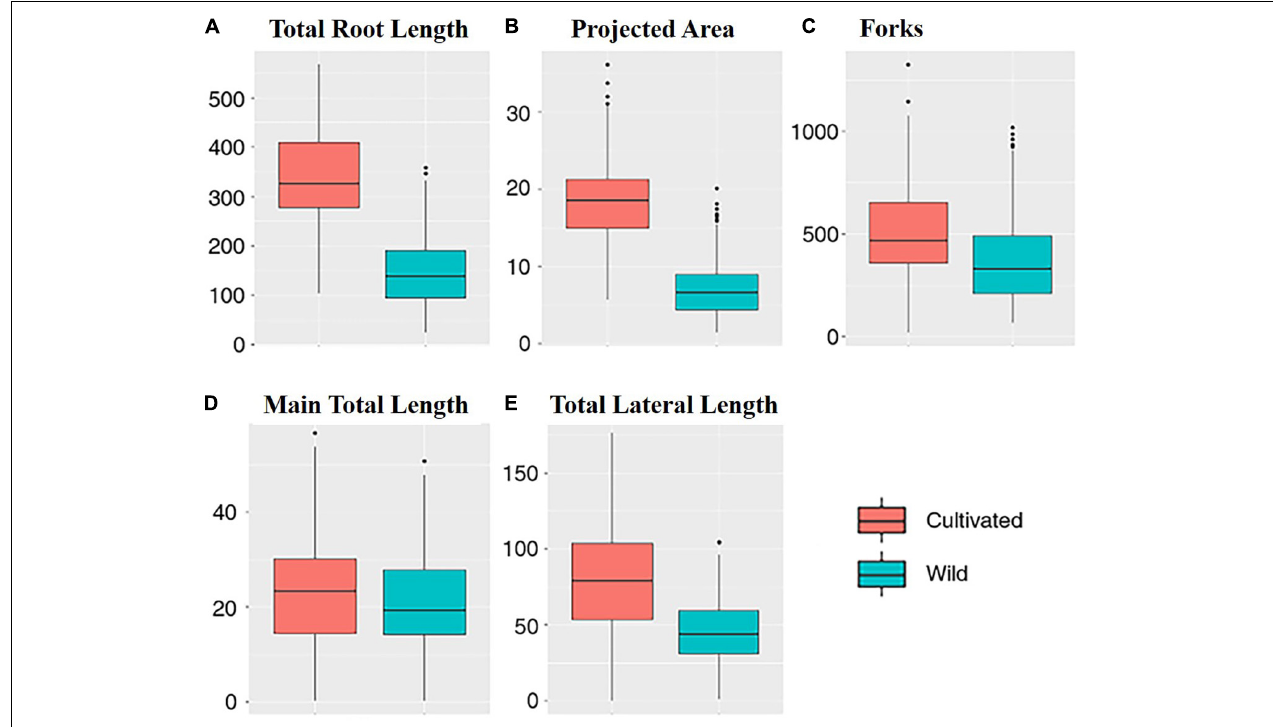
FIGURE 2 | Plot of each traits: (A) the total root length; (B) the projected area; (C) the forks; (D) the main total length; and (E) the total lateral length (blue, wild; red,